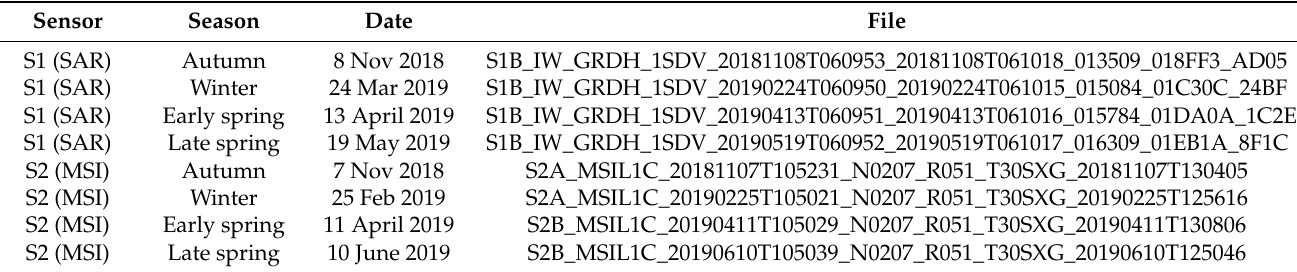
Table 1. Sentinel-1 and Sentinel-2 images used in this study.